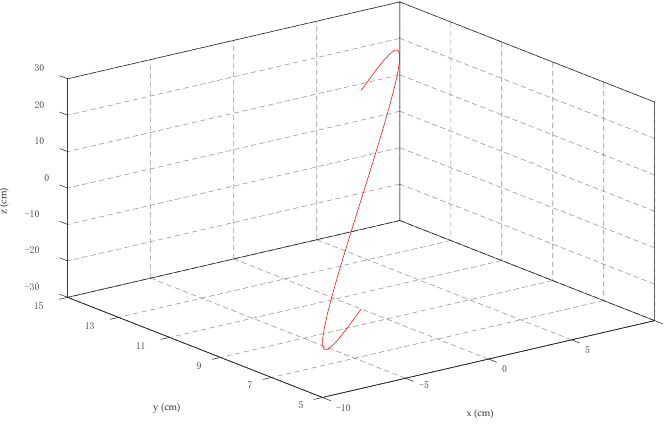
Figure 9. The end motion trajectory of the robot in the case of Equation (44).